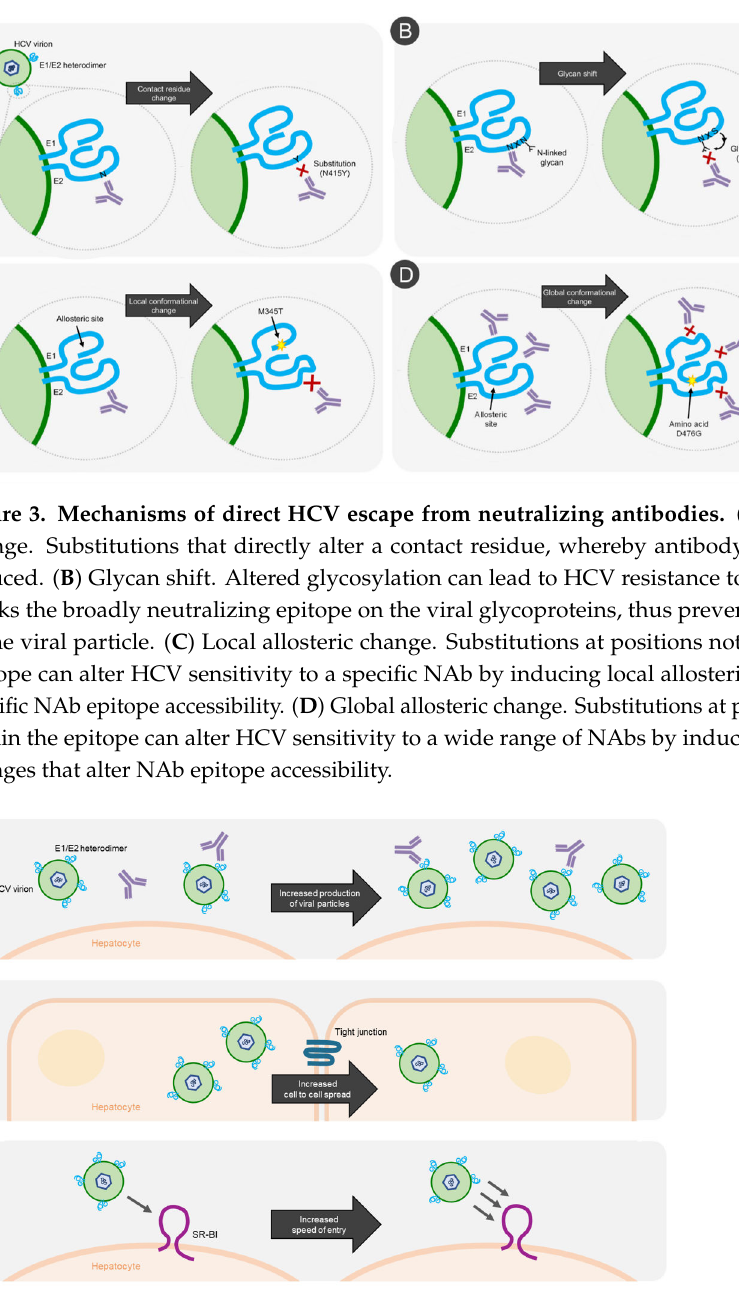
Figure 4. Indirect HCV neutralizing antibody escape by increased viral fitness, cell-to-cell spread, and speed of entry. HCV mutations can lead to ( A ) increased production of viral particles, thus increasing the number of infectious particles at any given concentration of antibody; ( B ) increased cell-to-cell spread, resulting in an increase in viral particles avoiding NAbs present in the extracellular environment; and ( C ) increased speed of entry, affording NAbs in shorter time to interact with their epitopes on the viral particles in the extracellular